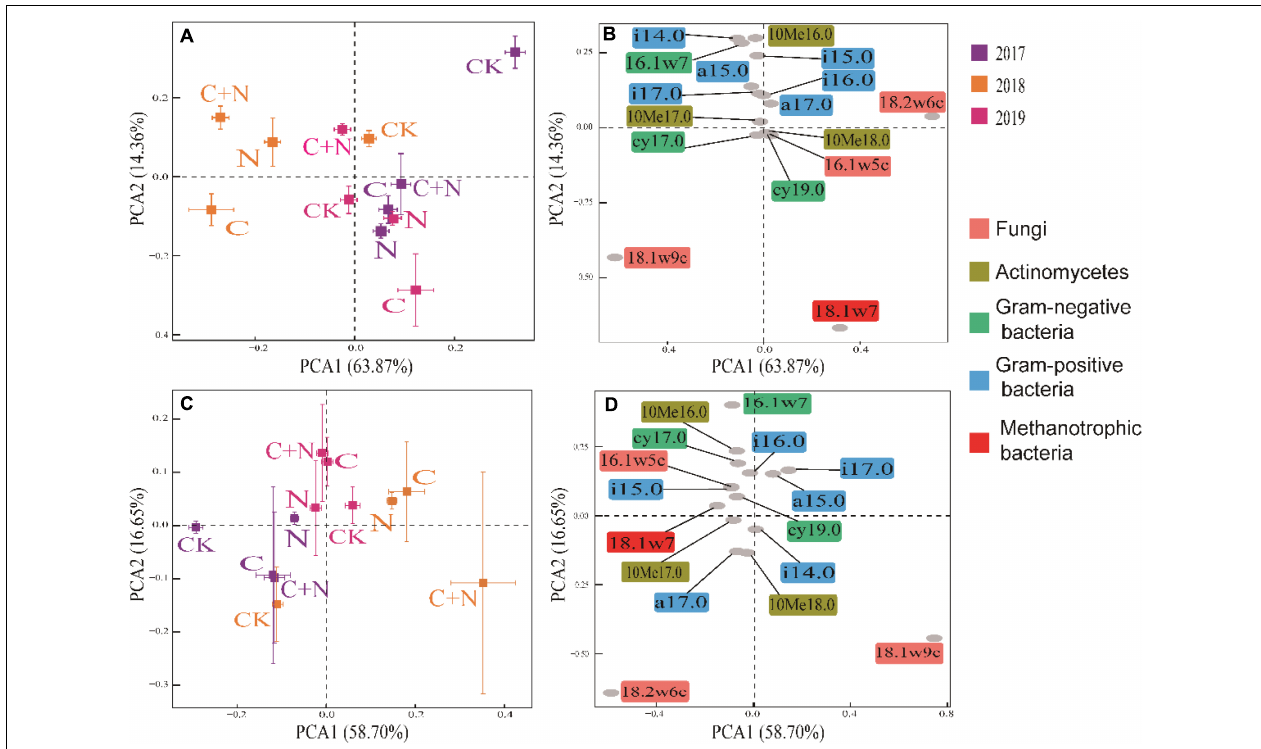
FIGURE 4 | Principal component analysis (PCA) of soil microbial community within different soil layers under different treatments in 2017, 2018, and 2019. (A) Treatment coordinates of 0–10 cm soil layer; (B) soil microorganism coordinates of 0–10 cm soil layer; (C) treatment coordinates of 10–20 cm soil layer; and (D) soil microorganism coordinates of 10–20 cm soil